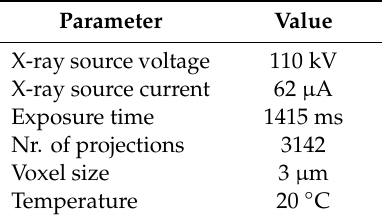
Table 2. Computed tomography (CT)-scanning parameters for the implants before the